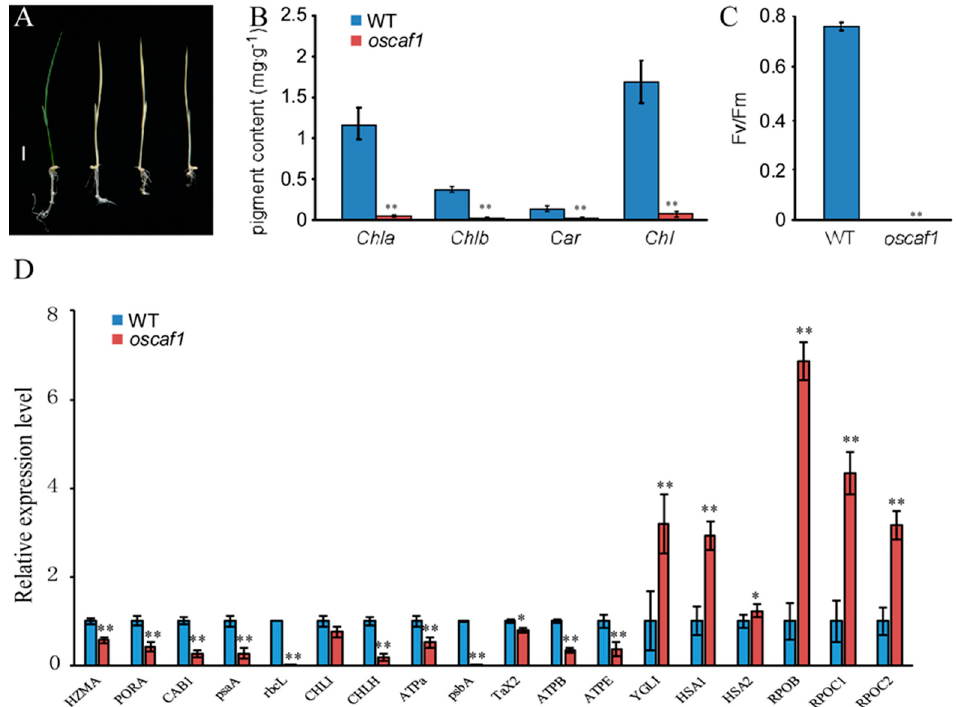
Figure 2. oscaf1 showed defects in chloroplast development and photosynthesis. ( A ) Phenotype observations of WT (left) and oscaf1 mutant (right). Scale bar, 1 cm. ( B ) Pigment content of WT and oscaf1 at seedling stage. ( C ) Photochemical efficiency of PSII in the light (Fv/Fm) of WT and oscaf1 mutants at seedling stage. ( D ) Relative expression levels of chloroplast development and photosynthesis genes in WT and oscaf1 mutants. The data represent mean ± SE from three independent biological duplicate, * and ** indicated p < 0.05 and p < 0.01, respectively.